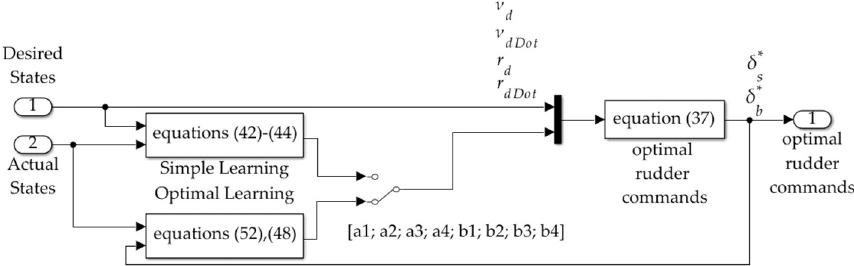
Figure 6. Topology (using actual SIMULINK model) of optimal rudder commands whose block has embedded the assertion of self-awareness; simple learning (using proportional + derivative components); and optimal learning (vis a vis the two-norm error optimal pseudoinverse solution).